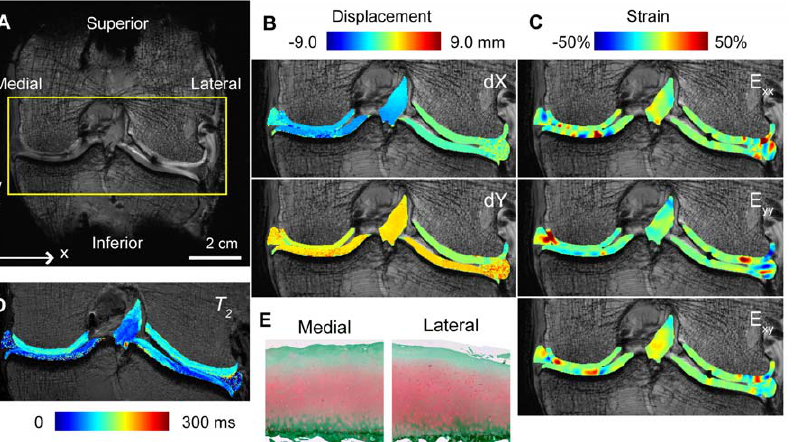
Figure 6. DENSE-FISP for displacements and strains in a complex system inclusive of broad T 2 materials. A human cadaveric tibiofemoral joint was cyclically loaded in the inferior-to-superior direction for DENSE-FISP imaging of a coronal slice ( A ). Displacements ( B ) and strains ( C ) in human tibiofemoral joint show non-homogeneous behavior in the articular cartilage, meniscus, and ligament. DENSE-FISP measures displacements in tissues that range in T 2 values ( D ). Cartilage sections stained with Safranin-O depict some histological signs of degeneration on the medial and lateral femoral condyles ( E ).